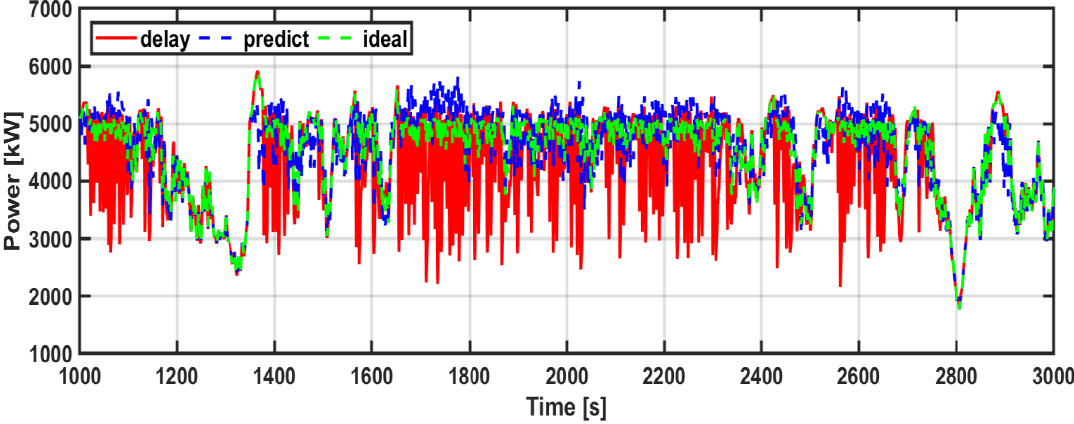
Figure 12. Output power of floating offshore wind turbine by pitch controller.